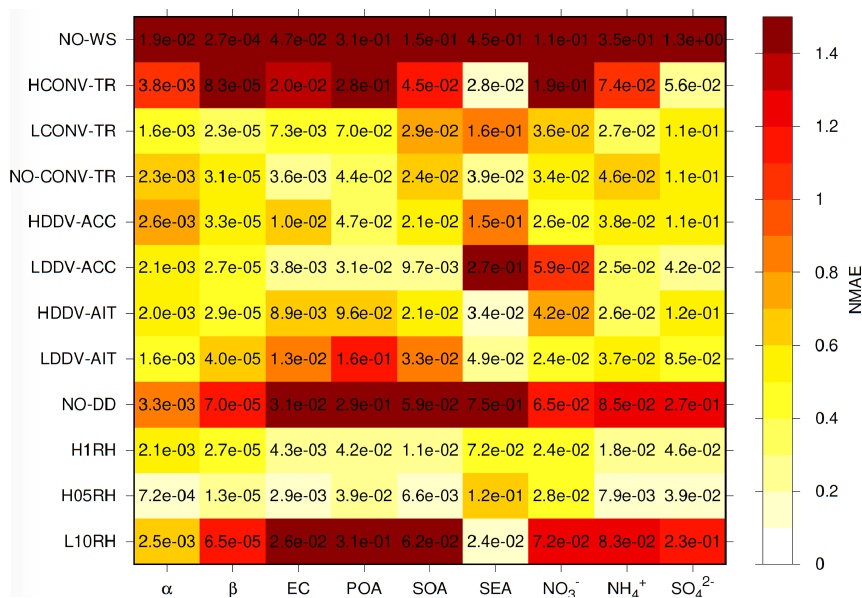
Figure 6. As Fig. 4 but over the MIN-AOD